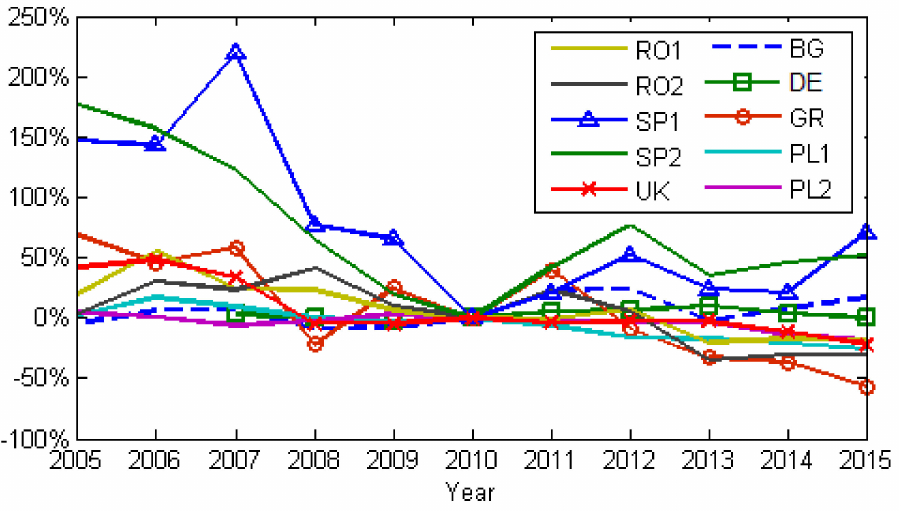
Figure 9. Changes in NO x emissions relative to 2010, the milestone being NEC